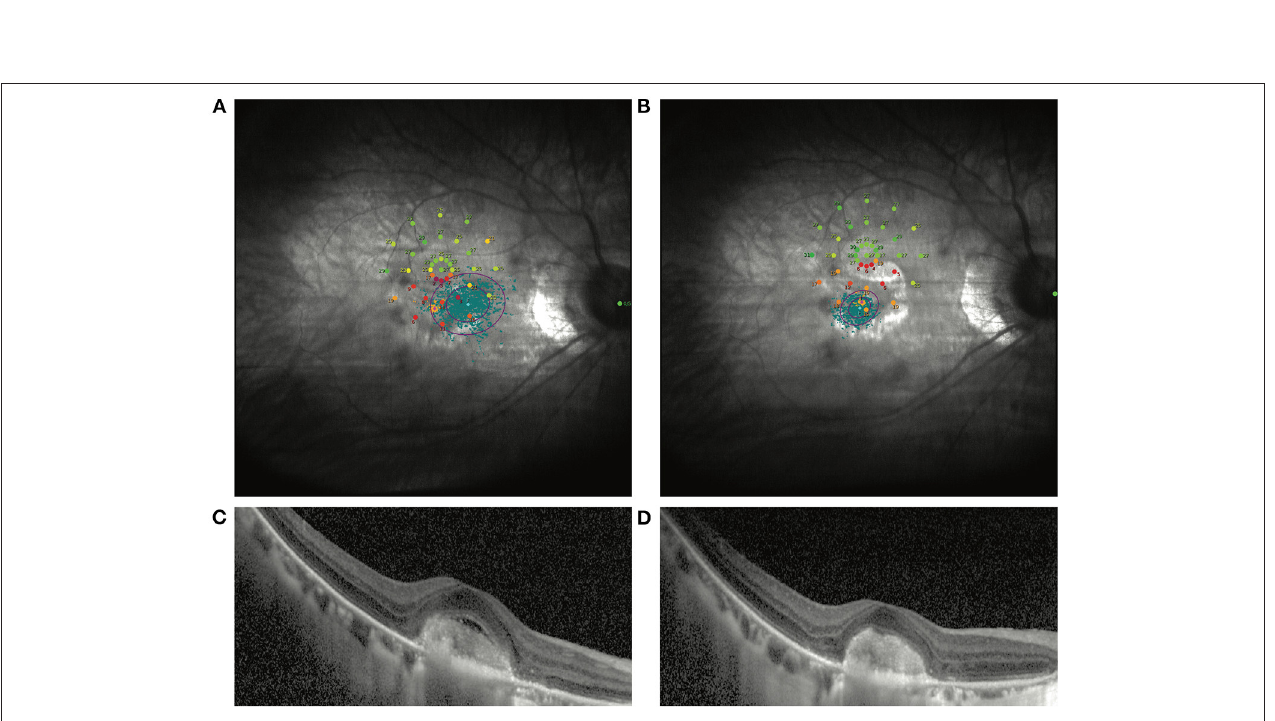
FIGURE 2 | Another representative patient without VA improvement after ranibizumab treatment. (A) Shows the image of the MP1 before ranibizumab treatment in an mCNV patient with baseline BCVA as 35 ETDRS letters. After treatment, the VA increased by 3 ETDRS letters. Nevertheless, the macular sensitivity and fixation improved dramatically by MP1 (B) . OCT images also show the remission of the CNV lesion in the macular (C,D) .